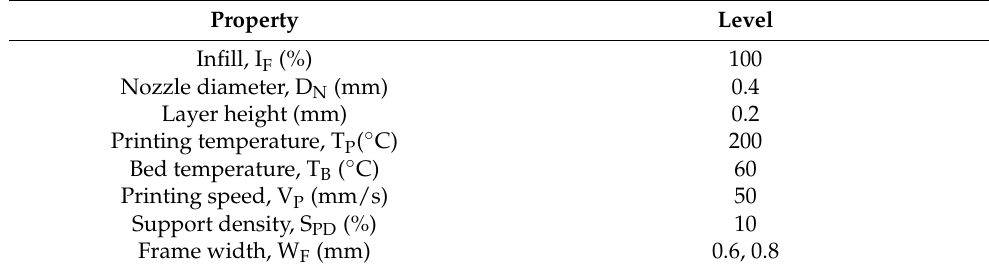
Table 2. Fixed printing parameters used in this study.